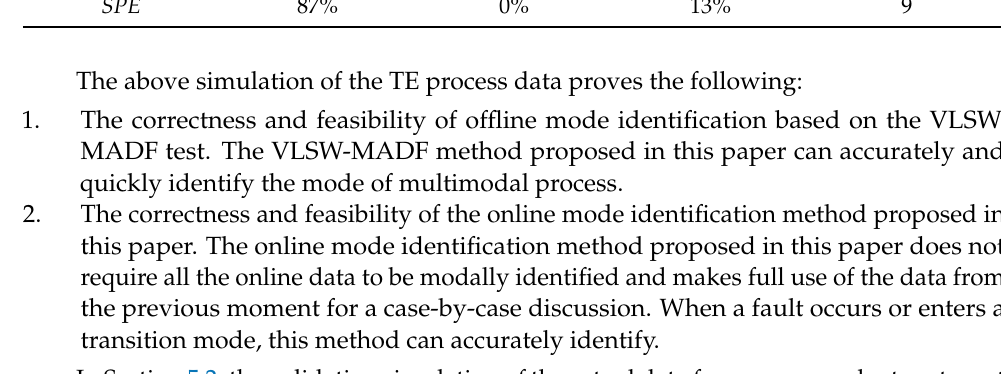
Table 3. Seven variables included in the steam feed pump system.